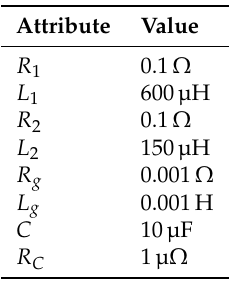
Figure 11. Single phase inverter with LCL output filter connected to an equivalent grid represented by a voltage source with series impedance R g and L g . Table 3. Inverter simulation example